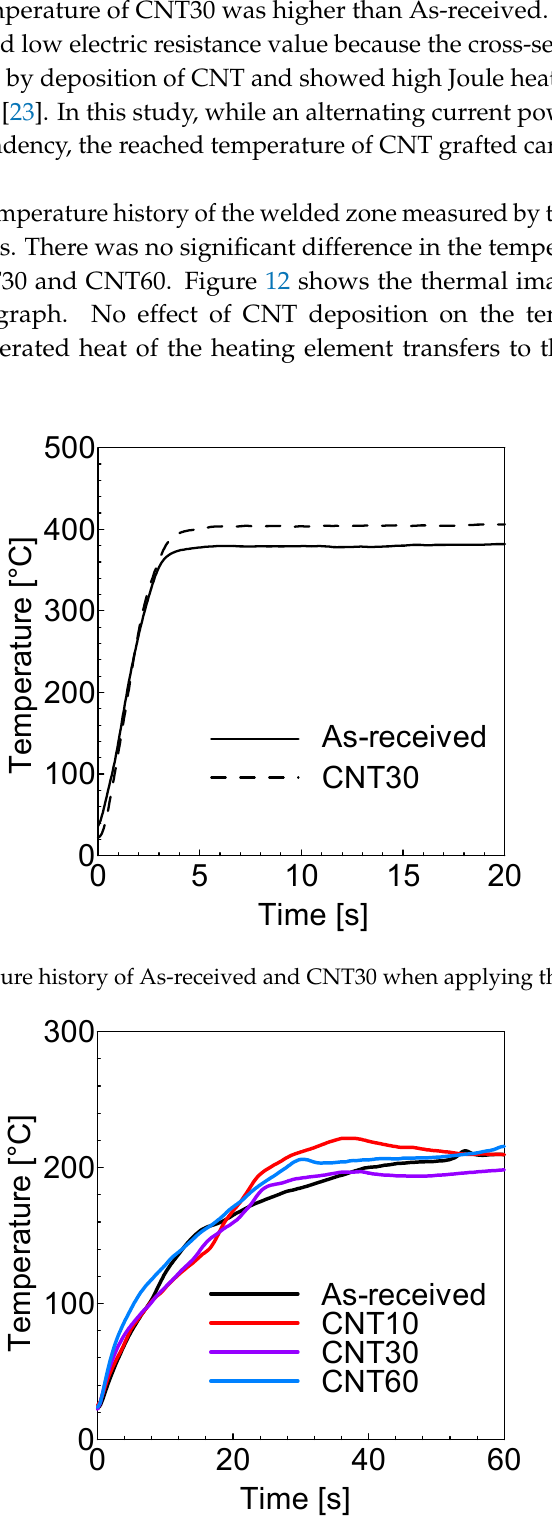
Figure 11. Temperature history of the welded zone during the welding process.